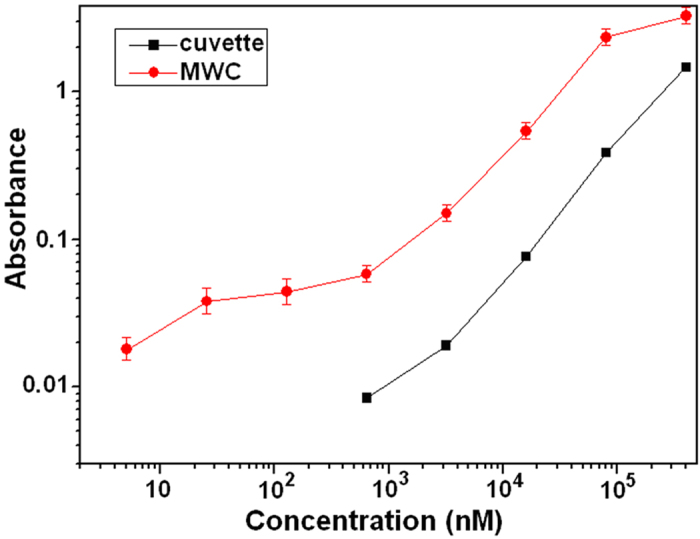
The relationship between the absorbance and concentration of the glucose samples.